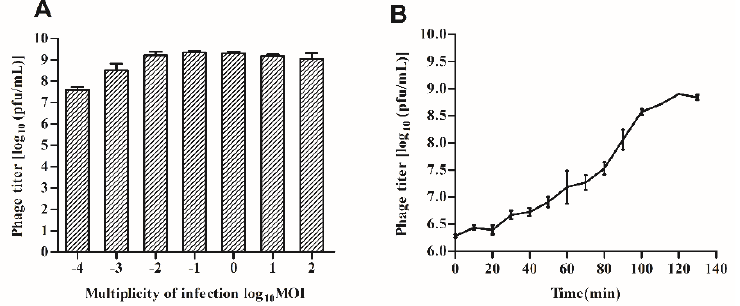
Figure 2. Biological characterization of vB_VpaP_GHSM17. ( A ) MOI; ( B ) one step growth curve.